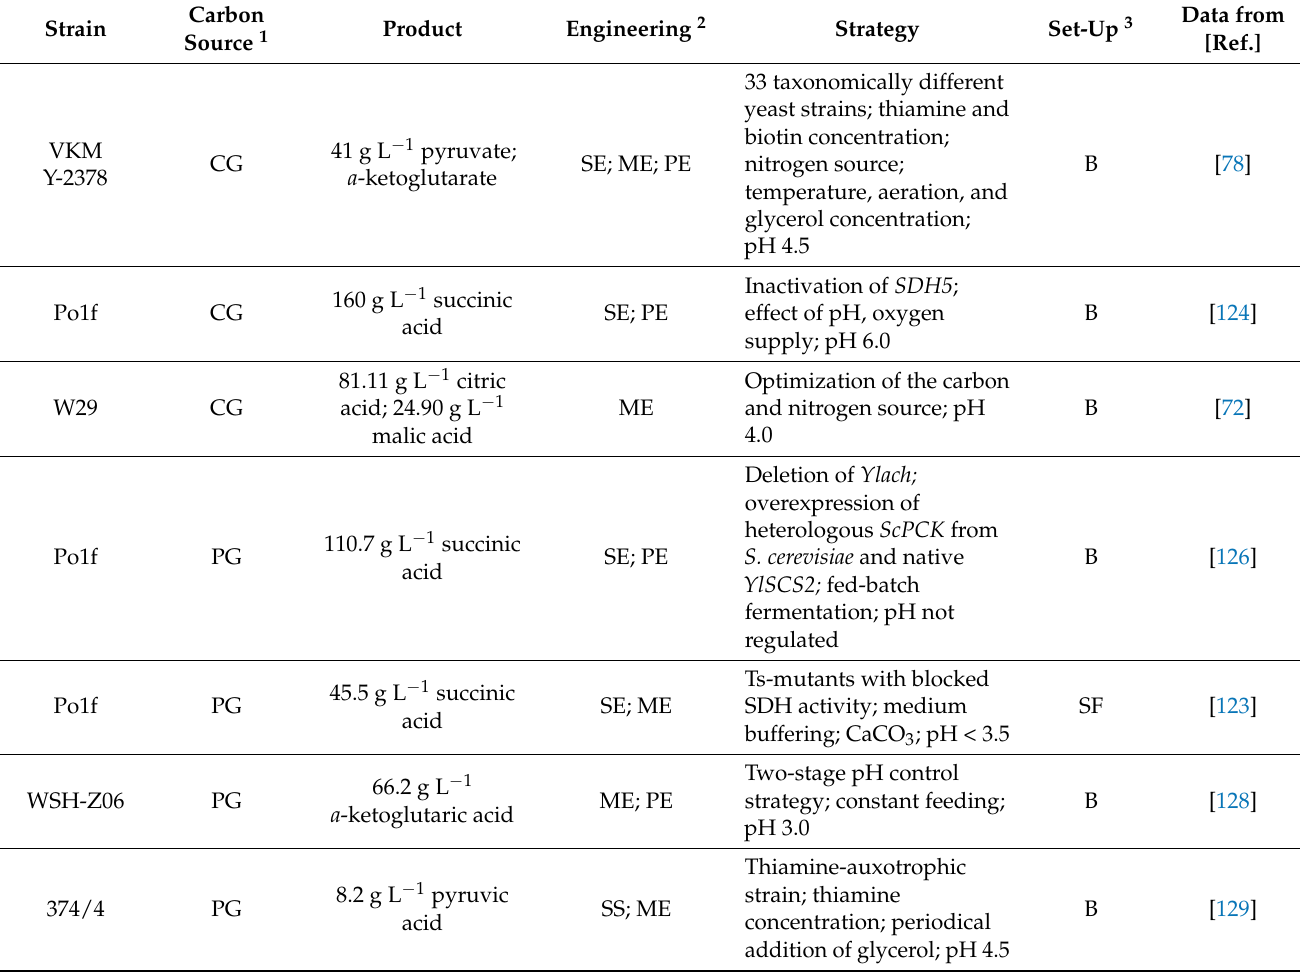
Table 4. Engineering strategies (strain, medium, process) and cultivation systems using pure glycerol as carbon source for the production of organic acids by Y. lipolytica